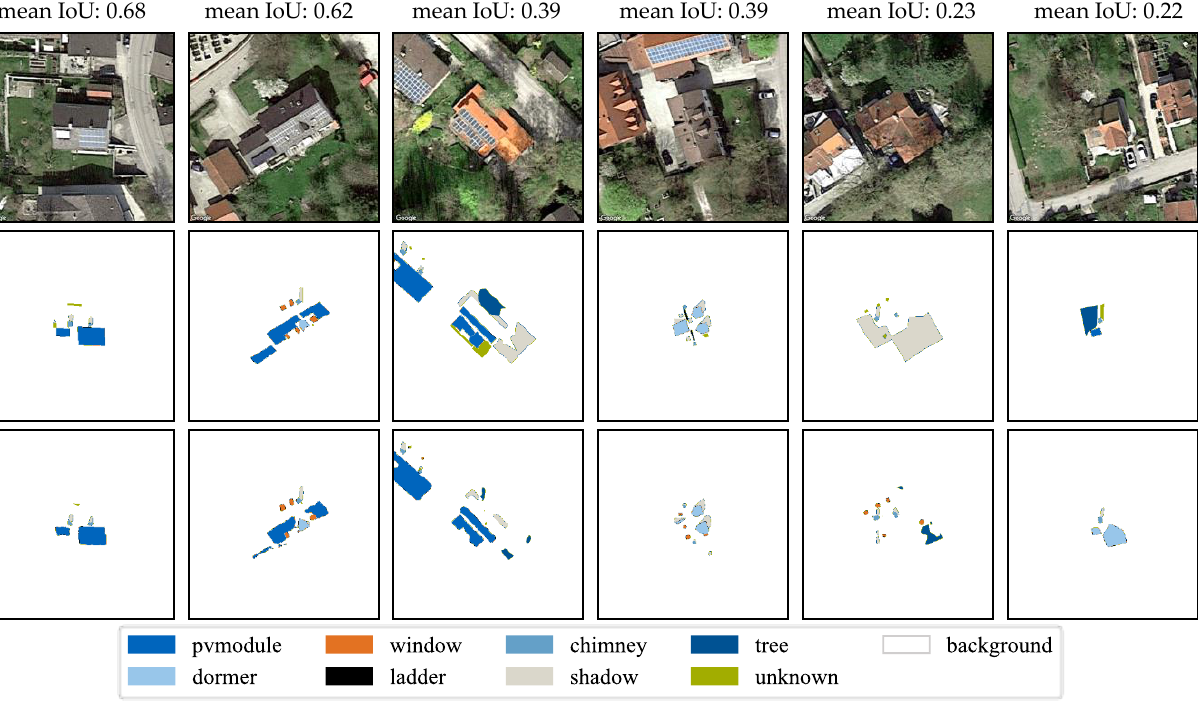
Figure 9. Visualization of six images with high, medium, and low mean IoUs including ground truth (second row) and prediction (bottom row). Pixels of roofs that were not part of the annotation experiment were set to the background for ground truth and prediction.